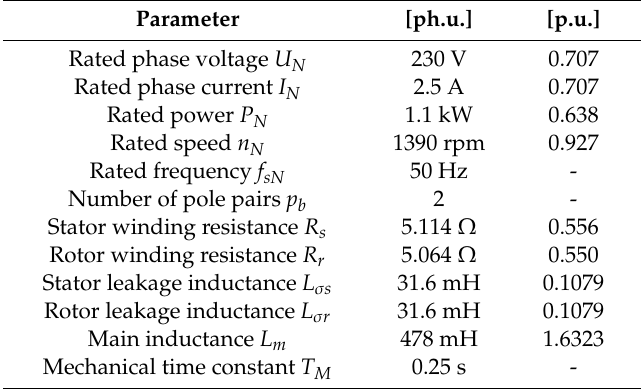
Table A1. Rated parameters of the IM tested in the simulation and